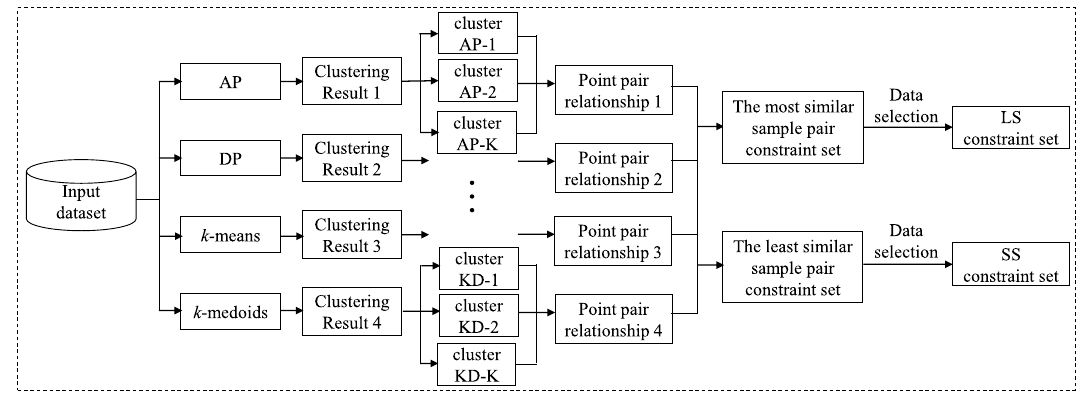
Fig. 1 Generation process of pairwise